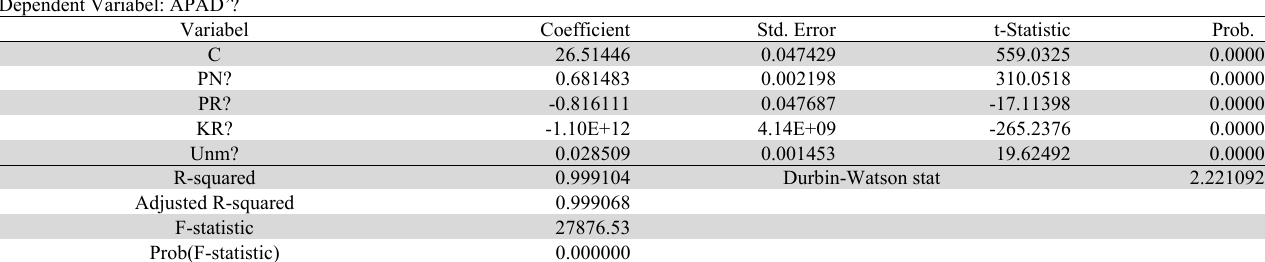
Results of Statistical Analysis of Equations (4) Model